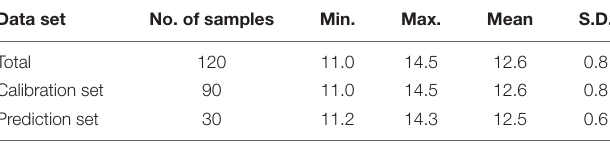
TABLE 1 | The statistics of SSC ( ◦ Brix) of all samples.